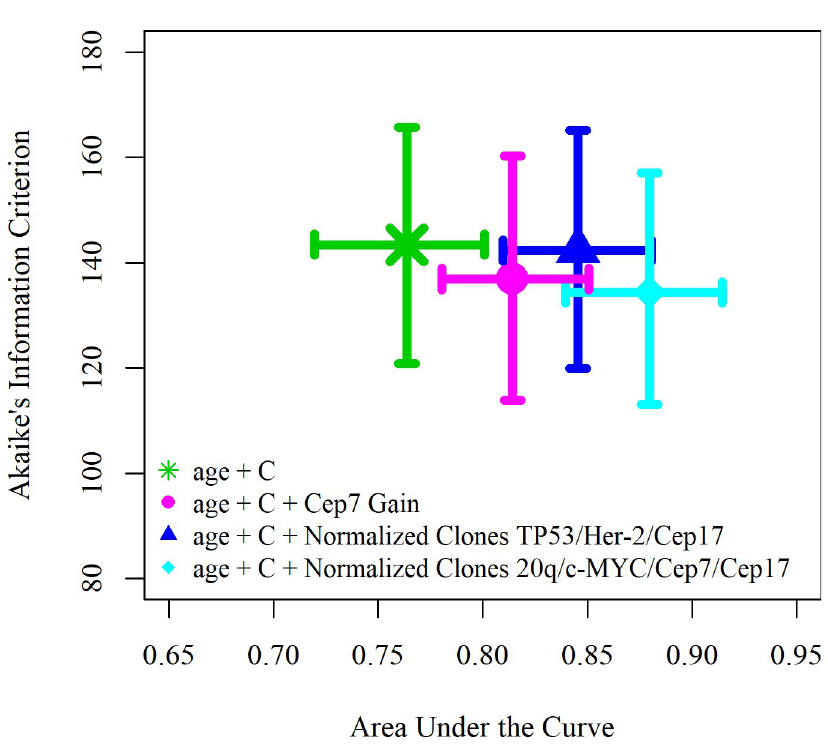
Fig 1. Area under the curve and Akaike Information Criterion of several models with a subset of variables in each model split up in multiple segments by splines. C, C-Barrett length.